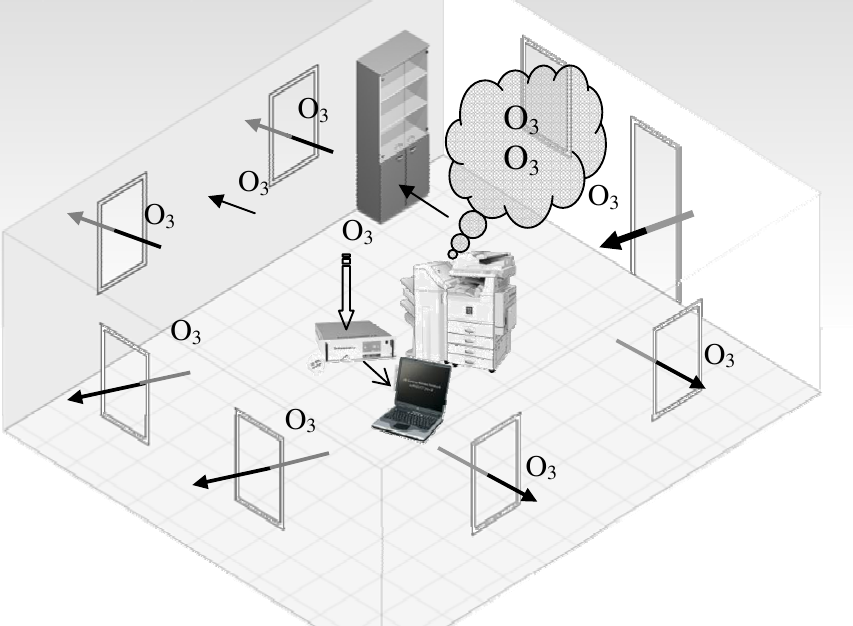
Fig 1. Ozone formation and decay pathways in room during experiment